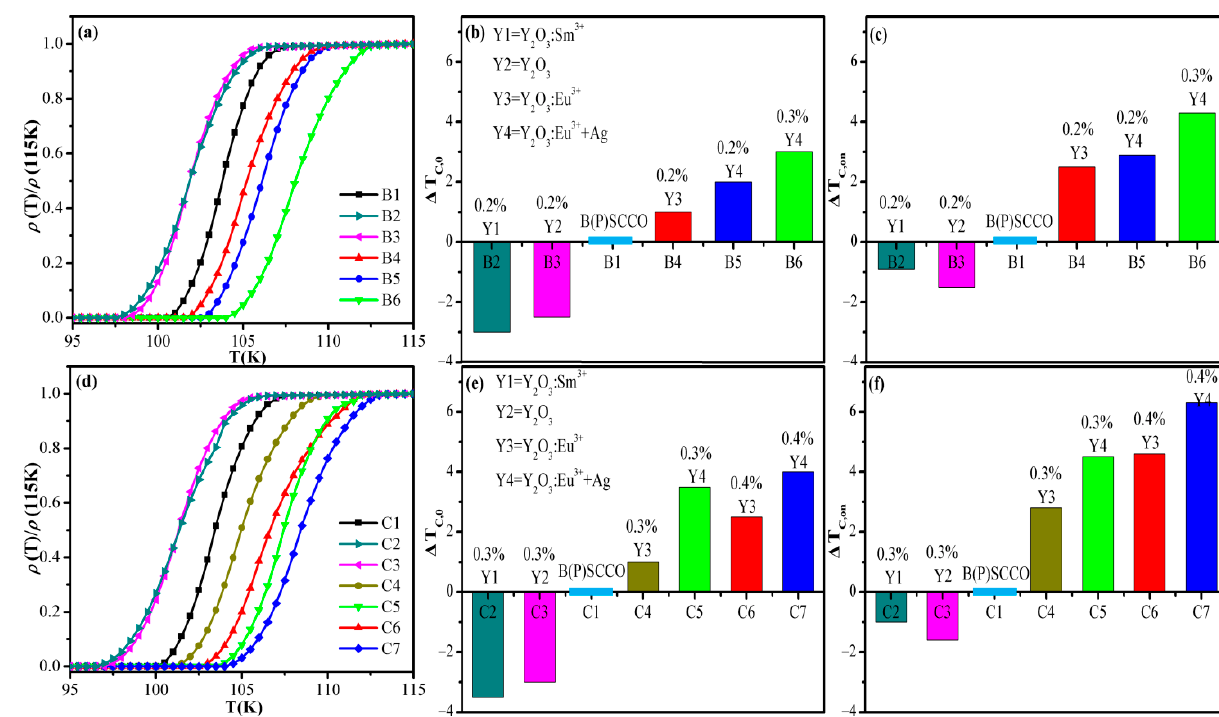
Figure 5. Superconductivity of B and C series samples. ( a ) Normalized R-T curves of pure B(P)SCCO (B1) and B(P)SCCO doped with 0.2 wt% Y 2 O 3 :Sm 3+ (B2), 0.2 wt% Y 2 O 3 (B3), 0.2 wt% Y 2 O 3 :Eu 3+ (B4), 0.2 wt% Y 2 O 3 :Eu 3+ +Ag (B5), and 0.3 wt% Y 2 O 3 :Eu 3+ +Ag (B6). ( b , c ) The Δ T C, 0 and Δ T C,on of B2, B3, B4, B5, and B6 relative to B1. ( d ) Normalized R-T curves of pure B(P)SCCO (C1) and B(P)SCCO doped with 0.3 wt% Y 2 O 3 :Sm 3+ (C2), 0.3 wt% Y 2 O 3 (C3), 0.3 wt% Y 2 O 3 :Eu 3+ (C4), 0.3 wt% Y 2 O 3 :Eu 3+ +Ag (C5), 0.4 wt% Y 2 O 3 :Eu 3+ (C6), and 0.4 wt% Y 2 O 3 :Eu 3+ +Ag (C7). ( e , f ) The Δ T C, 0 and Δ T C,on of C2, C3, C4, C5, C6, and C7 relative to C1.